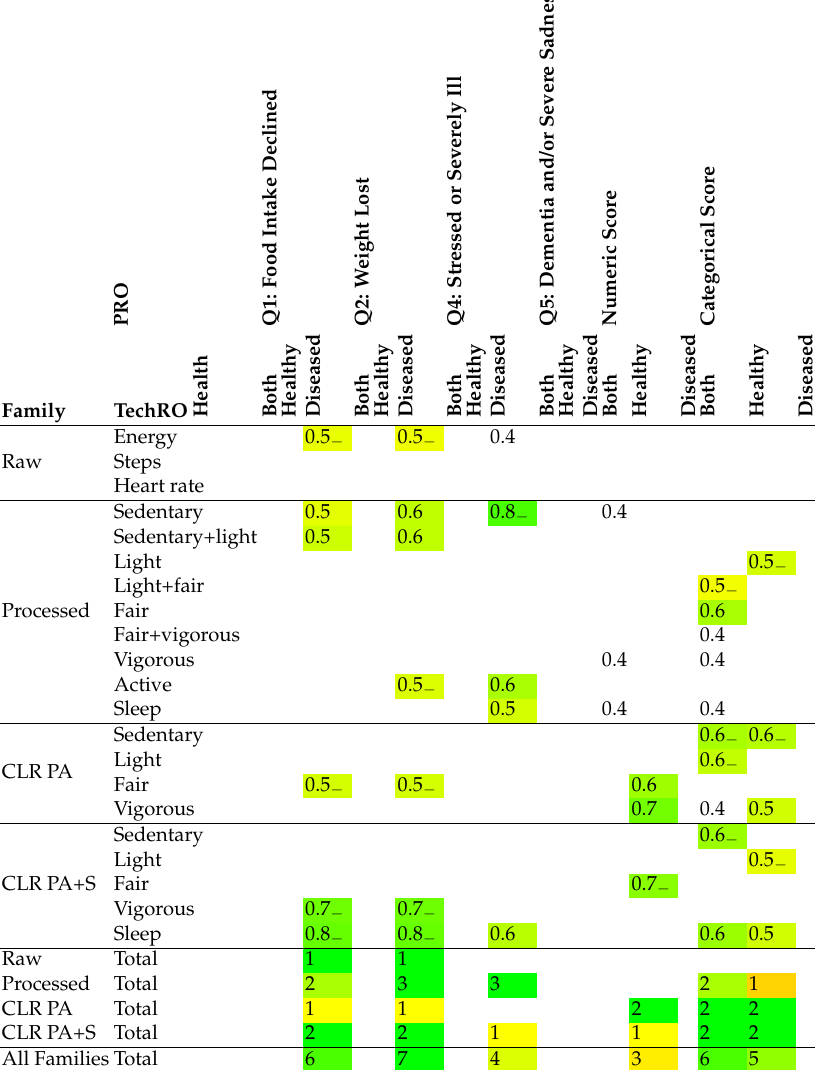
Color coding: from orange (weaker correlation/fewer total correlations) to yellow to green (stronger correlation/more total correlations). Only significant correlations are shown. Only coefficients of 0.5 or above are